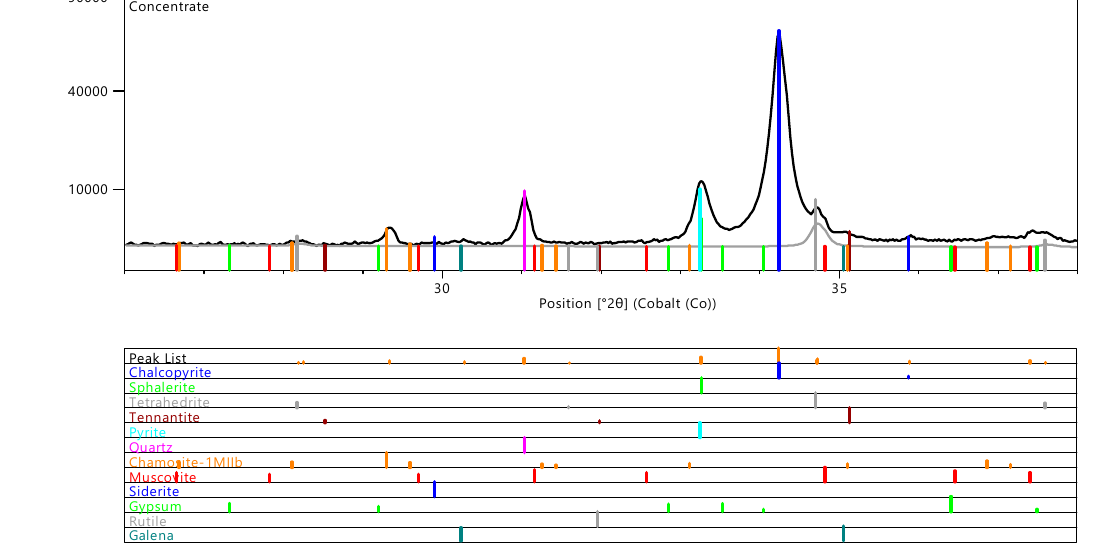
Figure 4. XRD pattern of ore concentrate in the range 26–38 ◦ 2 θ . Upper curve represents measured data, lower curve in gray represents Rietveld contribution of 1.6 wt% of tetrahedrite. Vertical bars are peak positions of crystalline phases.